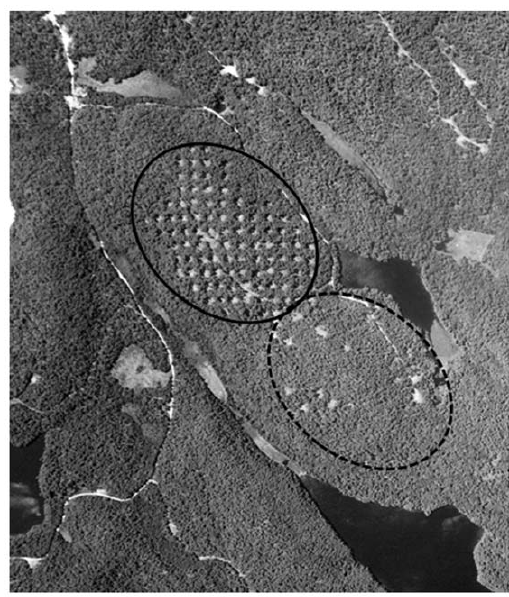
Figure 1. Aerial image of two forest stands cut with group- selection silviculture (GSS) in Algonquin Provincial Park. Heavy group-selection is outlined with a solid line in the upper left and Moderate group-selection is outlined with a dotted line in the bottom right. Undisturbed sites are similar to the unharvested forest in the upper right of the image (Source: Algonquin Forestry Authority).